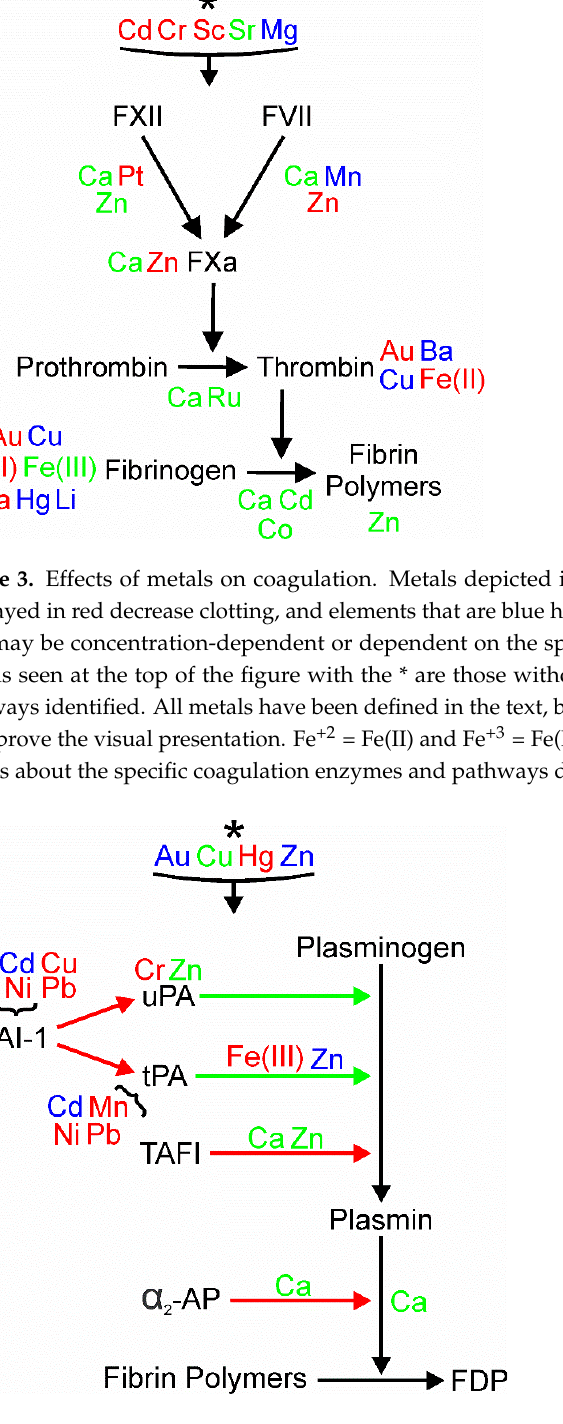
Figure 4. Effects of metals on fibrinolysis. Metals depicted in green enhance fibrinolysis, those displayed in red decrease clot dissolution, and elements that are blue have conflicting effects on fibrinolysis that may be concentration-dependent or dependent on the species source of the plasma or